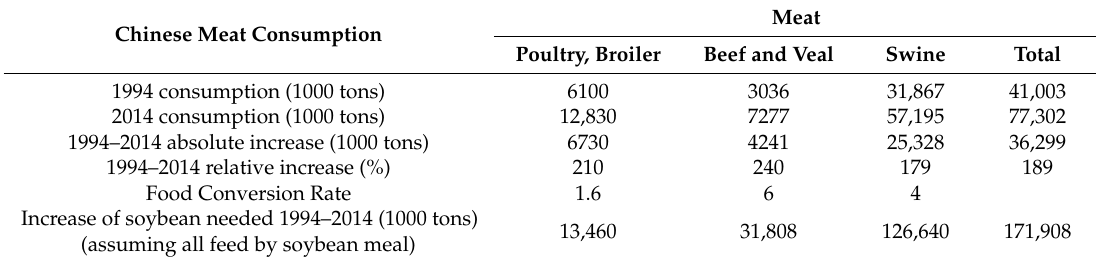
Table 4. Increasing demand for soybean based on meat consumption in China. Data source: